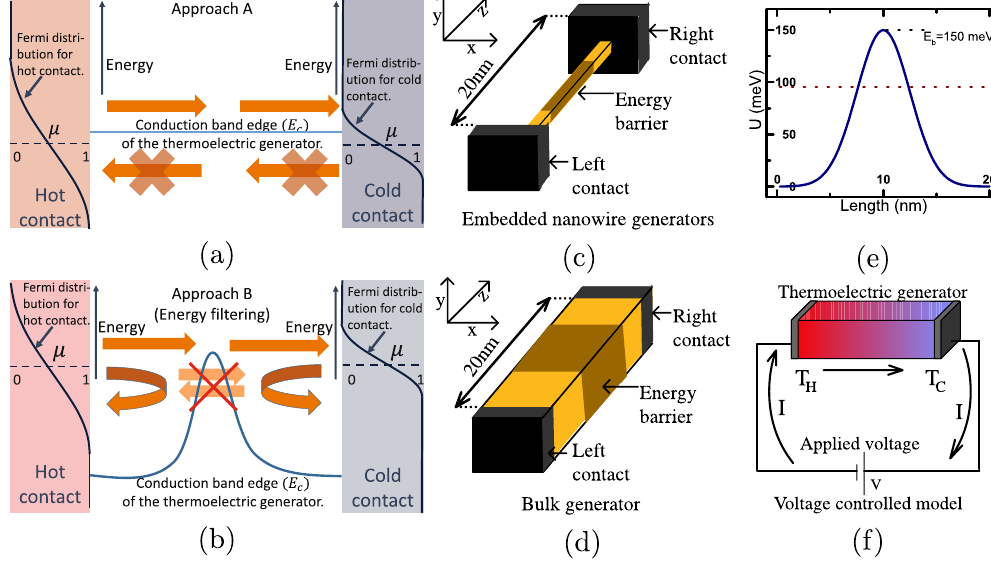
Figure 1. ( a , b ) Schematics depicting the two common approaches of improving the thermoelectric performance. ( a ) Approach A: Enhancing the thermoelectric generation by tuning the position of Fermi energy near the conduction band edge and ( b ) Approach B: enhancing the thermoelectric performance by energy filtering via embedding a nano barrier within the thermoelectric generator. The hot and cold contacts are assumed to be macroscopic bodies in equilibrium with the quasi Fermi energy μ at temperature T H and T C respectively. ( c , d ) The device used for simulation, with a device region of length 20 nm comprising ( c ) embedded nanowire thermoelectric generator ( d ) bulk thermoelectric generator. The shaded region in both the cases represents the embedded barrier (in case of Approach B). ( e ) The band profile of the device region of length 20 nm , embedded with a Gaussian energy barrier of height E b = 150 meV and width σ w = 2.7 nm . The brown dotted line shows the Fermi energy of the device for the case E b − μ 0 = 2 k B T . ( f ) Schematic of the voltage controlled model used to simulate the power-efficiency trade-off